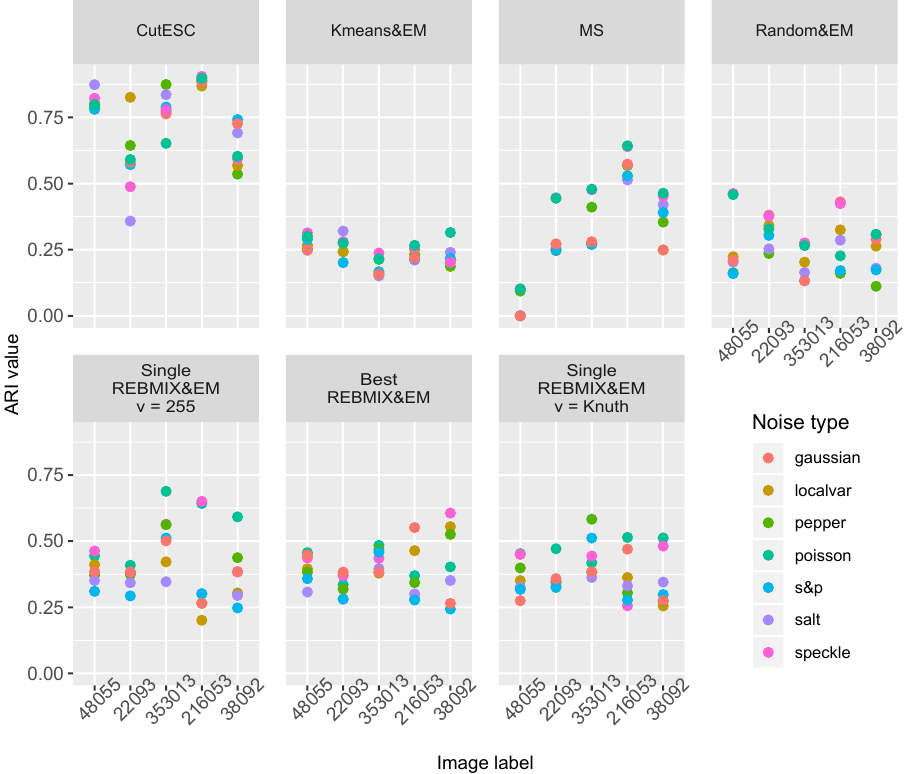
Figure 11. Segmentation results on images with applied